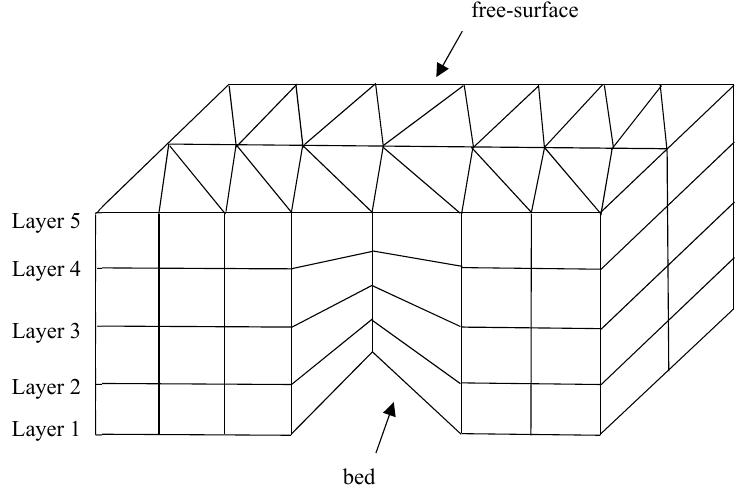
Figure 1. A 3D mesh of TELEMAC-3D model built from a 2D